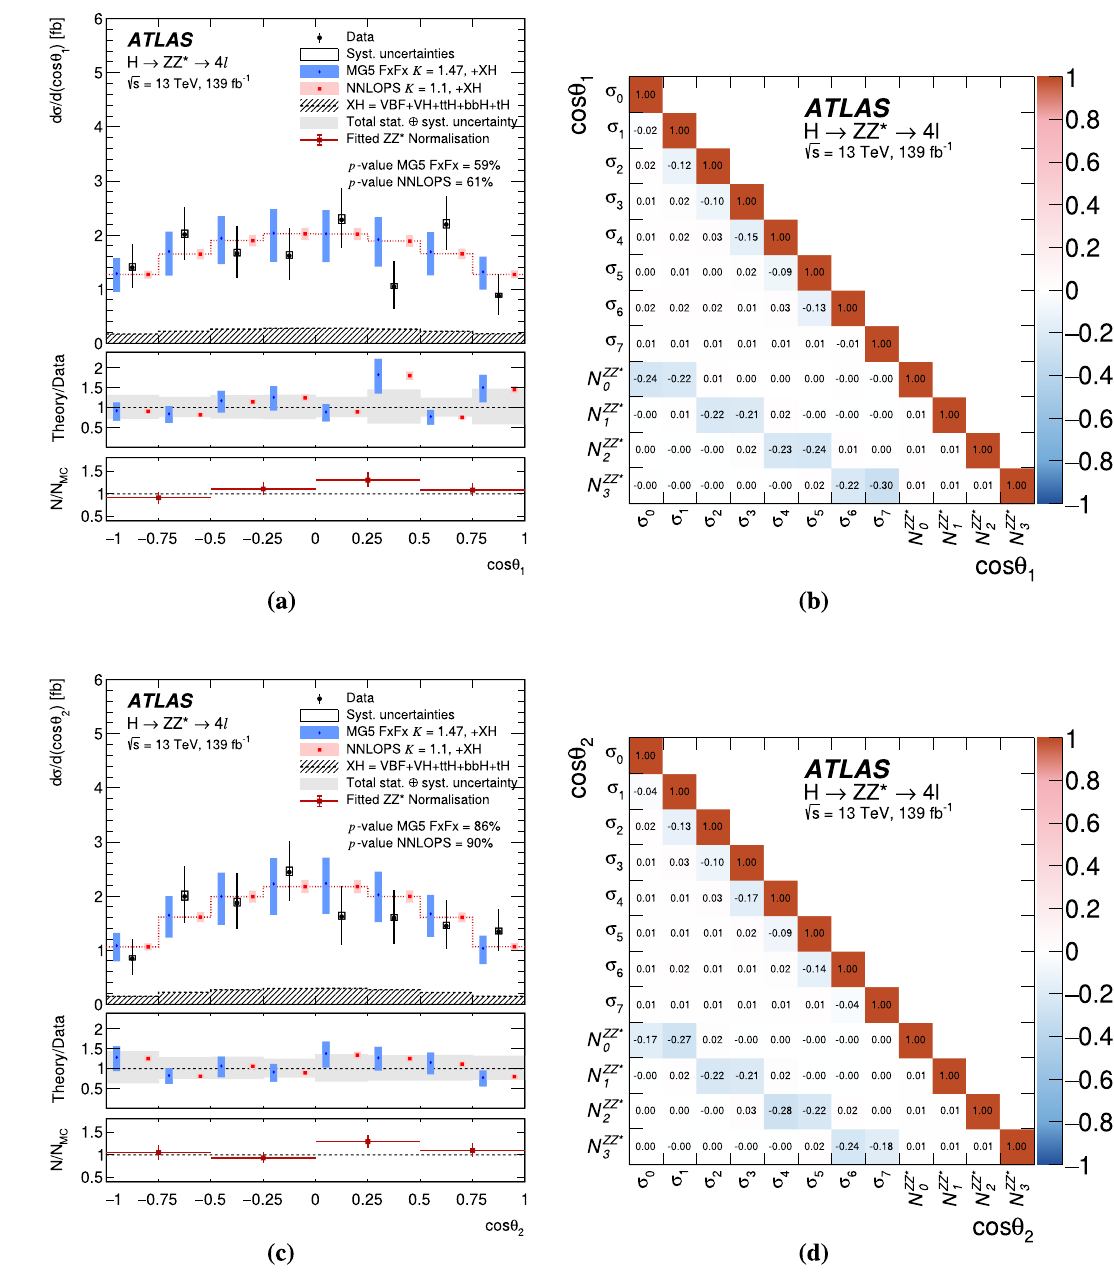
Fig. 22 Differential fiducial cross sections for a production angle, cos θ 1 , of the anti-lepton from the leading Z boson and c the production angle, cos θ 2 , of the anti-lepton from the subleading Z boson. The cor-